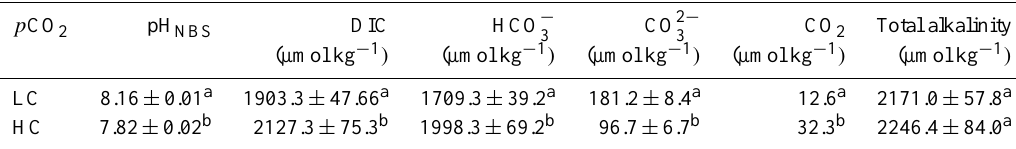
Table 1. Mean ( ± SD, n = 24) values of parameters of the seawater carbonate system under LC (ambient, 390µatmCO 2 ) and HC (enriched, 1000µatmCO 2 ) during the eight days prior to experiments. The superscripts represent significant difference between LC and